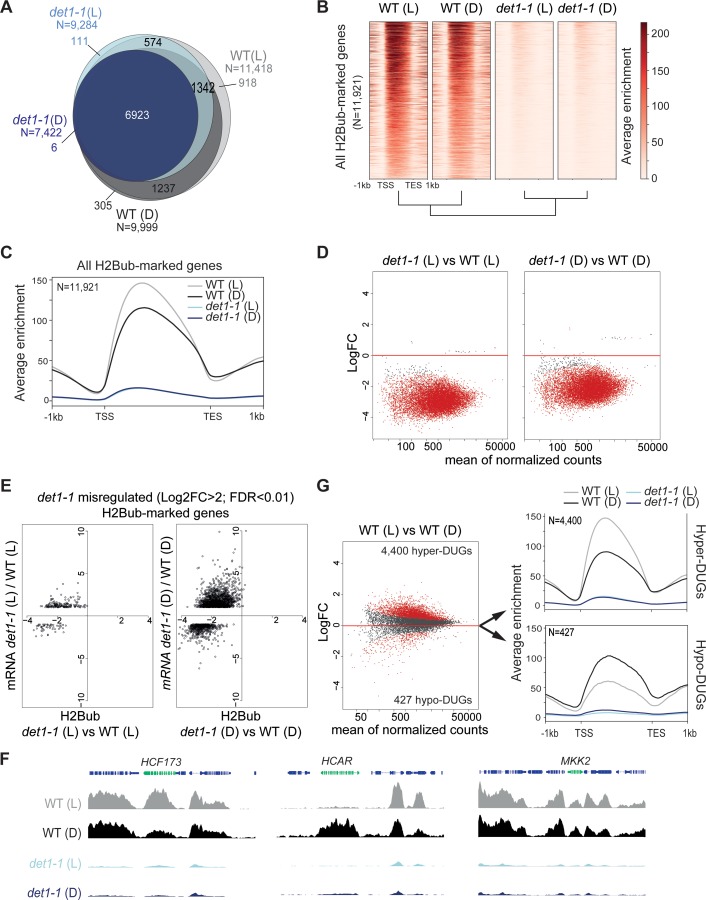
Light and DET1 massively influence H2Bub enrichment over protein-coding genes.(A) Number of H2Bub-marked genes in 5-day-old wild-type (WT) and det1-1 seedlings grown under light (L) or dark (D) conditions. A gene was considered as being marked when overlapping a H2Bub peak in each of the two biological replicates. (B) Heatmap showing dramatically low H2Bub levels over H2Bub-marked genes in det1-1 seedlings. Genes are ranked from top to down according to H2Bub level in the WT (L) sample. (C) Metagene plot of H2Bub distribution over the coding regions of the 11,921 H2Bub-marked genes in the four sample types. (D) Identification of differentially ubiquitinated genes (DUGs) by Rx-normalized DESeq2 analysis (FDR < 0.01) shows that det1-1 mutation triggers low H2Bub levels over almost all genes. Dots represent the full set of genes displaying a H2Bub domain (according to MACS2 peak detection, see Materials and methods) in at least one sample type. Red dots correspond to differentially ubiquitinated genes (DUGs; FDR < 0.01). (E) In both dark and light conditions, massive misregulation of gene expression occurred in a globally hypo-ubiquitinated H2B landscape in det1-1 plants. Scatter plots show the correspondence between H2Bub and gene expression changes between WT and det1-1 plants on det1-1 misregulated genes in light (left) and dark (right) conditions. The x-axis shows Log2 fold-changes (FC) of H2Bub levels as determined by Rx-normalized DESeq2 analysis (FDR < 0.01). The y-axis shows expression Log2 fold changes of as determined by DESeq2 (>2 fold variation, FDR < 0.01). Only genes bearing a significant H2Bub domain according to MACS2 peak detection are shown. (F) Genome-browser snapshots showing H2Bub profiles in WT and det1-1 seedlings grown in light or dark conditions. MAP KINASE KINASE 2 (MKK2) is invariably expressed and marked by H2Bub under dark and light conditions. HIGH CHLOROPHYLL FLUORESCENCE (HCF173) is a hyper-DUG (Log2FC = 1.3) induced by light (Log2FC = 3.7) that was previously shown to require HUB activity for optimal inducibility by light (Bourbousse et al., 2012). In contrast, 7-HYDROXYMETHYL CHLOROPHYLL A (HCAR) is a hypo-DUG (Log2FC = −3.4) repressed by light (Log2FC = −0.7). (G) Similar analyses as in (C) and (D) showing a tendency towards higher H2Bub enrichment in light than in dark condition in wild-type plants. The 4400 hyper-DUGs and 427 hypo-DUGs in WT (L) versus WT (D) samples and their corresponding H2Bub meta-profile are shown. In (C) to (G) H2Bub levels were scaled according to ChIP-Rx normalization factors calculated for each sample type to adjust for quantitative IP/Input variations in H2Bub enrichment over the genome. In all analyses, each sample type is the mean of two independent biological replicates.10.7554/eLife.37892.007Figure 2—source data 1.Gene lists summarizing ChIP-Rx analysis of H2Bub levels in WT and det1-1 seedlings grown under dark or light conditions.10.7554/eLife.37892.008Figure 2—source data 2.RNA-seq identification of genes differentially expressed in WT, det1-1, ubp22-1 and det1-1ubp22-1 mutant lines grown under dark or light conditions using DESeq2.10.7554/eLife.37892.009Figure 2—source code 1.ChIP differential analyses.10.7554/eLife.37892.010Figure 2—source code 2.RNA-seq differential analyses.